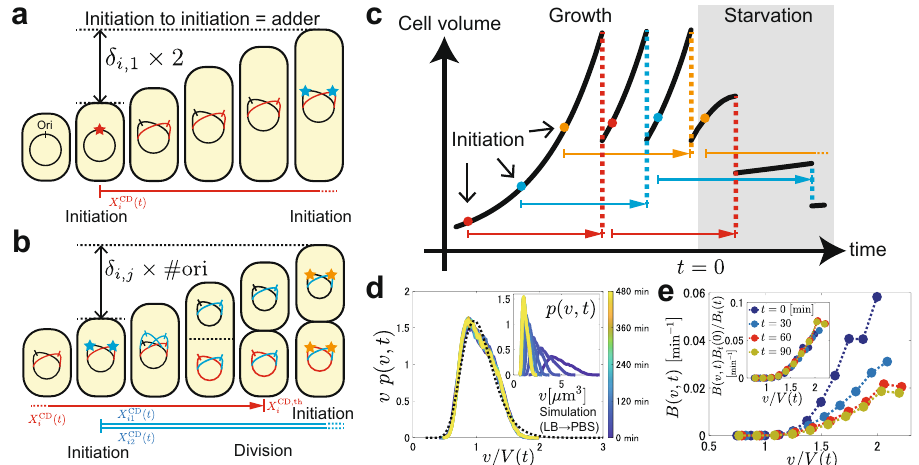
Fig. 4 Model of reductive division and simulation results. a , b Single ( a ) and multifork ( b , where # ori = 4) intracellular cycle processes. See Eq. (4) for the criterion that triggers the initiation. Progress of each cycle is represented by a coordinate X CD i ð t Þ , which increases at speed μ i ( t ) and ends at X CD i ð t Þ ¼ X CD ; th i by triggering cell division. c Illustration of cell cycles in this model. Each colored arrow represents a single intracellular cycle process. d Overlapping of the rescaled cell size distributions during starvation in the model for LB → PBS. The dashed line represents the fi tted log-normal distribution ( σ = 0.25(2)). (Inset) The non-rescaled cell size distributions at t ¼ 0 ; 5 ; 30 ; 60 ; 90 ; 120 ; 180 ; 240 ; 300 ; 360 ; 420 ; 480 min from right to left. e Numerically measured division rate, B ( v , t ), in the model for LB → PBS. See Supplementary Note 4.B for the measurement method. (Inset) Test of the condition of Eq. (9). Here B B t ) is evaluated by B B t ) = ∫ B ( xV (0), 0)d x / ∫ B ( xV ( t ), t )d x , with x running in the range 0 ≤ x ≤ 1.8. Overlapping of the data demonstrates that t (0)/ t ( t (0)/ t ( Eq. (9) indeed holds in our